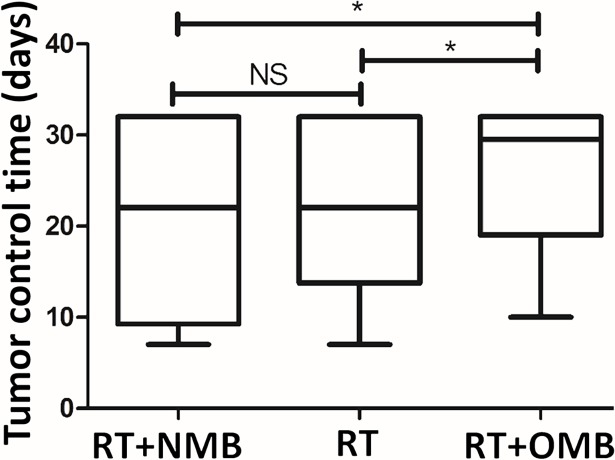
Tumor control time comparison between RT groups.OMB significantly improve RT outcome, whereas NMB as controls do not (n = 6 per group). Box-and-whisker plots show all data from the three radiotherapy treatment groups.